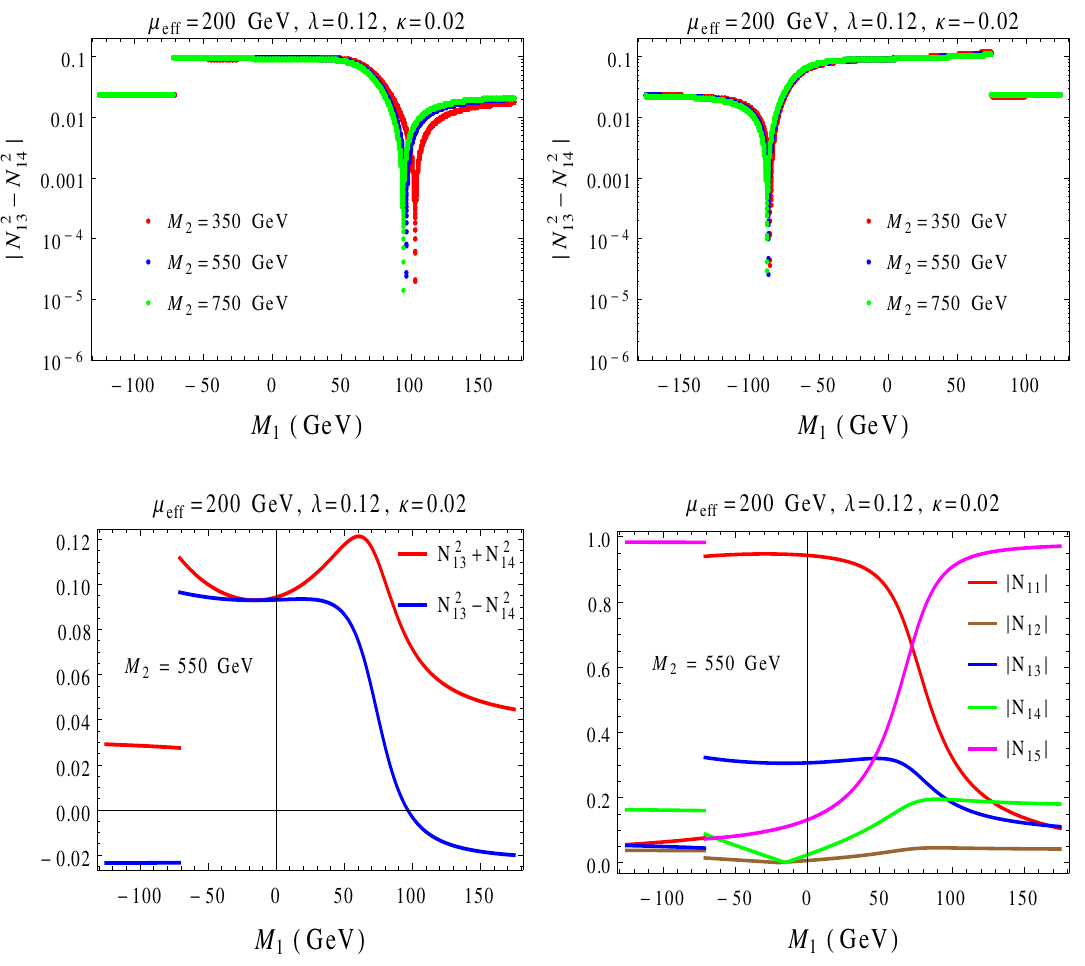
Figure 1 . Upper panel: variation of the quantity N 2 N 2 as a function of M 1 for three values 13 (cid:0) 14 j j of M 2 (350 GeV, 550 GeV and 750 GeV) for (cid:22) e(cid:11) = 200 GeV, (cid:21) = 0 : 12, and for (cid:20) > 0 ( < 0) for upper left (upper right) plot. Lower panel: corroborative plots showing variations of the actuals (signed) values of the quantities N 2 N 2 and N 2 + N 2 (left) and N 1 j ; ( j = 1 ; : : : ; 5) (right) as functions 13 (cid:0) 14 13 14 j j of M 1 for a (cid:12)xed value of M 2 (= 550 GeV). tan (cid:12) is set to 40 throughout. Values of (cid:12)xed input parameters are indicated at the top of each plot and are the same for all the plots. Plots are created using SARAH - v4.9.0 -generated [65, 66] NMSSM model and hence present tree-level values